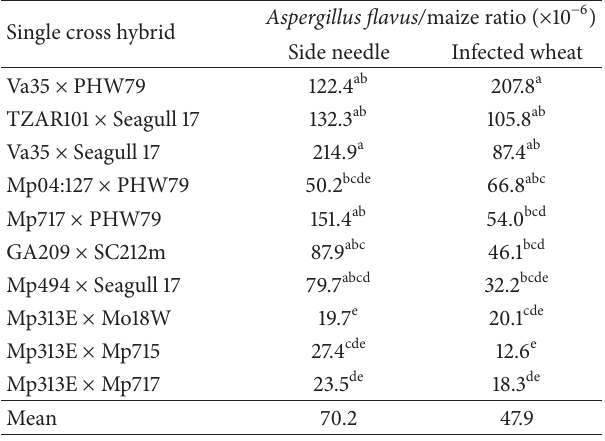
Table 2: Aspergillus flavus /maize ratio for 10 maize single cross hybrids following inoculation with A. flavus using the side needle technique or infected wheat in 2011 and